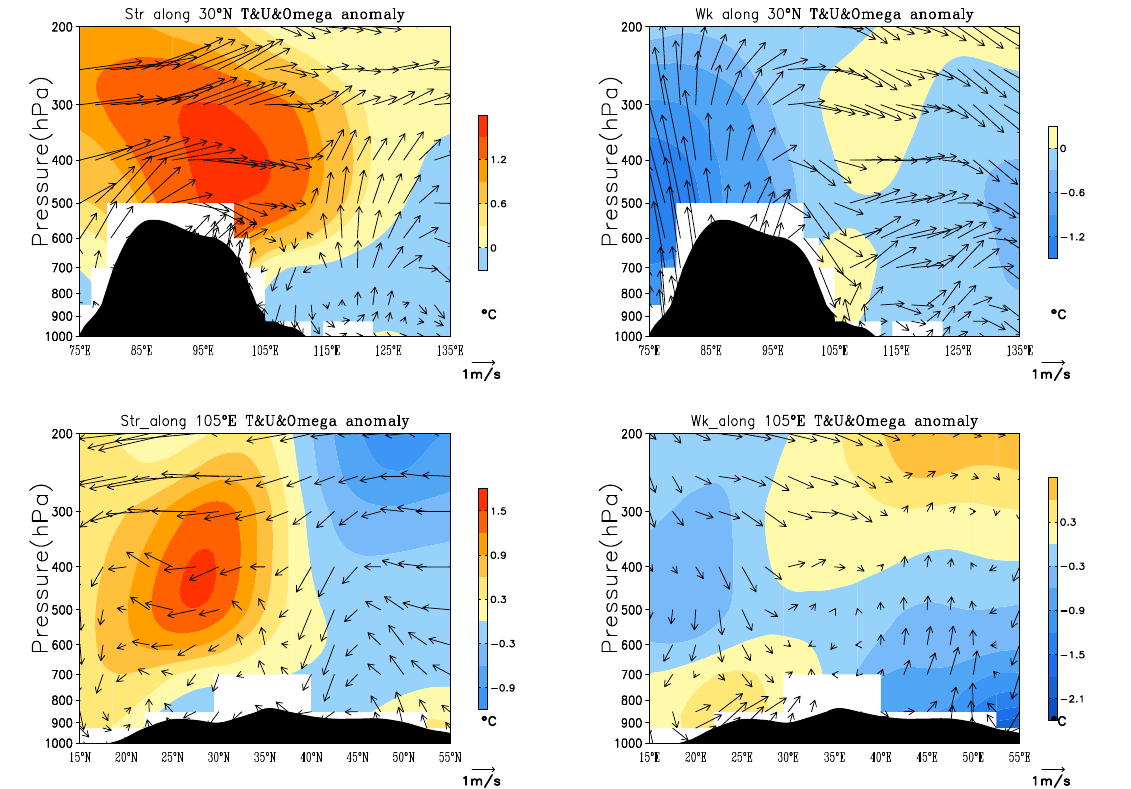
Figure 9. Circulation and temperature fields in east-west ( top ) and north-south ( bottom ) cross-section of the Sichuan-Chongqing region in strong ( left ) and weak ( right ) cold source years on the Qinghai-Tibet plateau.